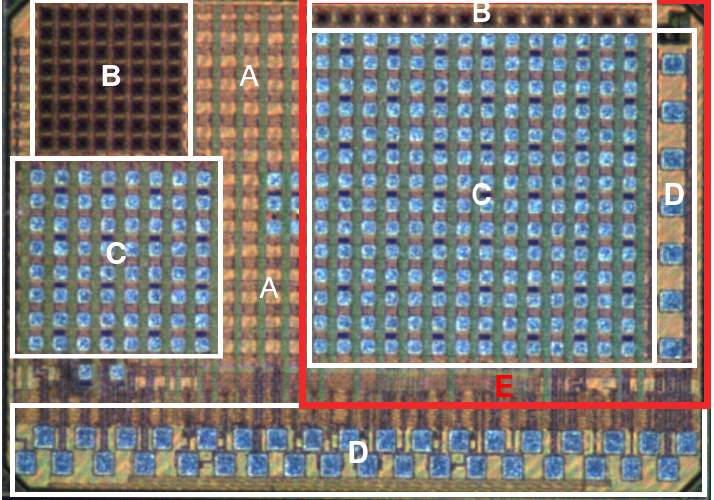
Figure 1. PDC diagram with the four main components: registers ( A ), SPADs ( B ), TDCs and quench- ing circuits ( C ), wirebonding pads ( D ). The rightmost array (red, E ) was designed for another application and is not described in this